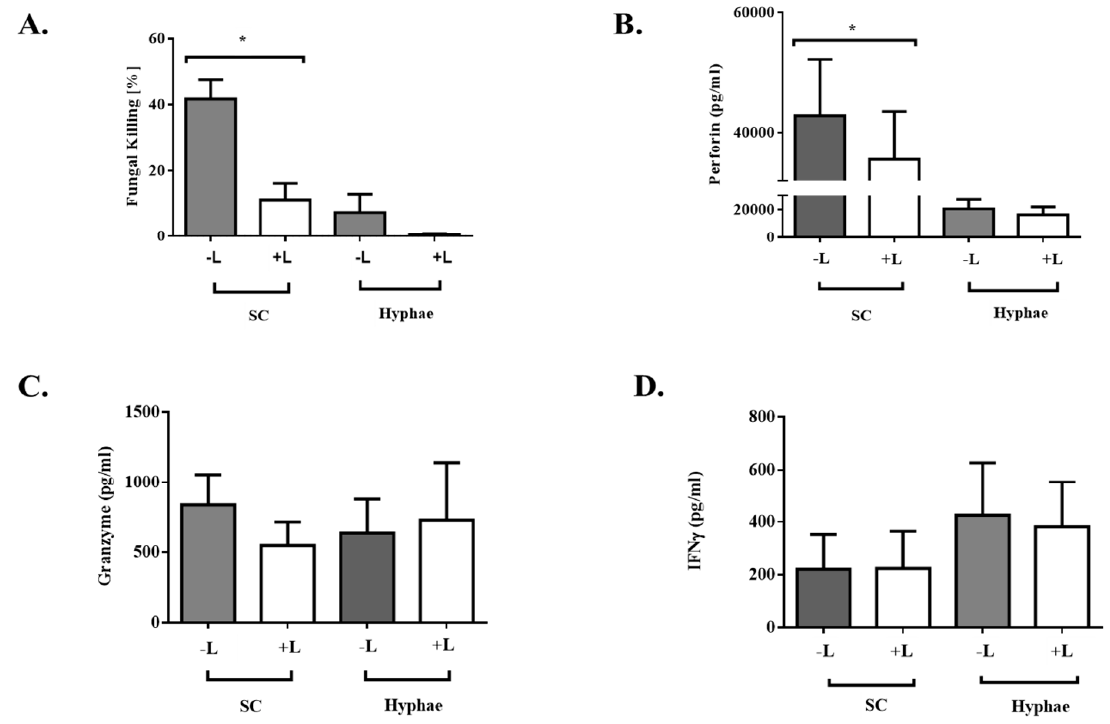
Figure 5. Dectin-1 inhibition assay with laminarin. Expanded NK cells were treated with laminarin for 1 h before exposure to the Aspergillus morphotypes (swollen conidia—SC and Hyphae—H) for 6 h. ( A ) XTT assay showing killing of swollen conidia and hyphae by cells treated with laminarin compared to the untreated cells (* p < 0.05). ( B ) Perforin levels in cells treated with laminarin compared to untreated cells (* p < 0.05). ( C ) Granzyme B levels and ( D ) IFN- γ production following blockade of dectin-1 receptors with laminarin. Data shown is representative of the mean of duplicate readings ( ± SEM) pooled from 3 experiments.